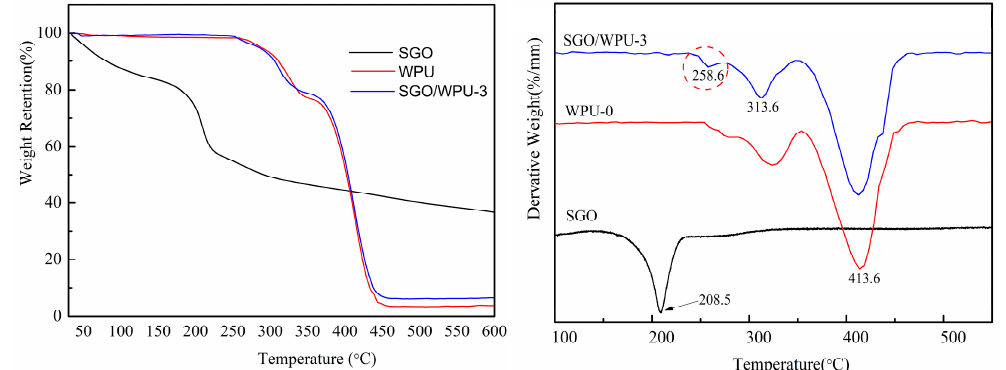
Figure 8. TGA curves of the SGO, WPU and SGO/WPU nanocomposites.